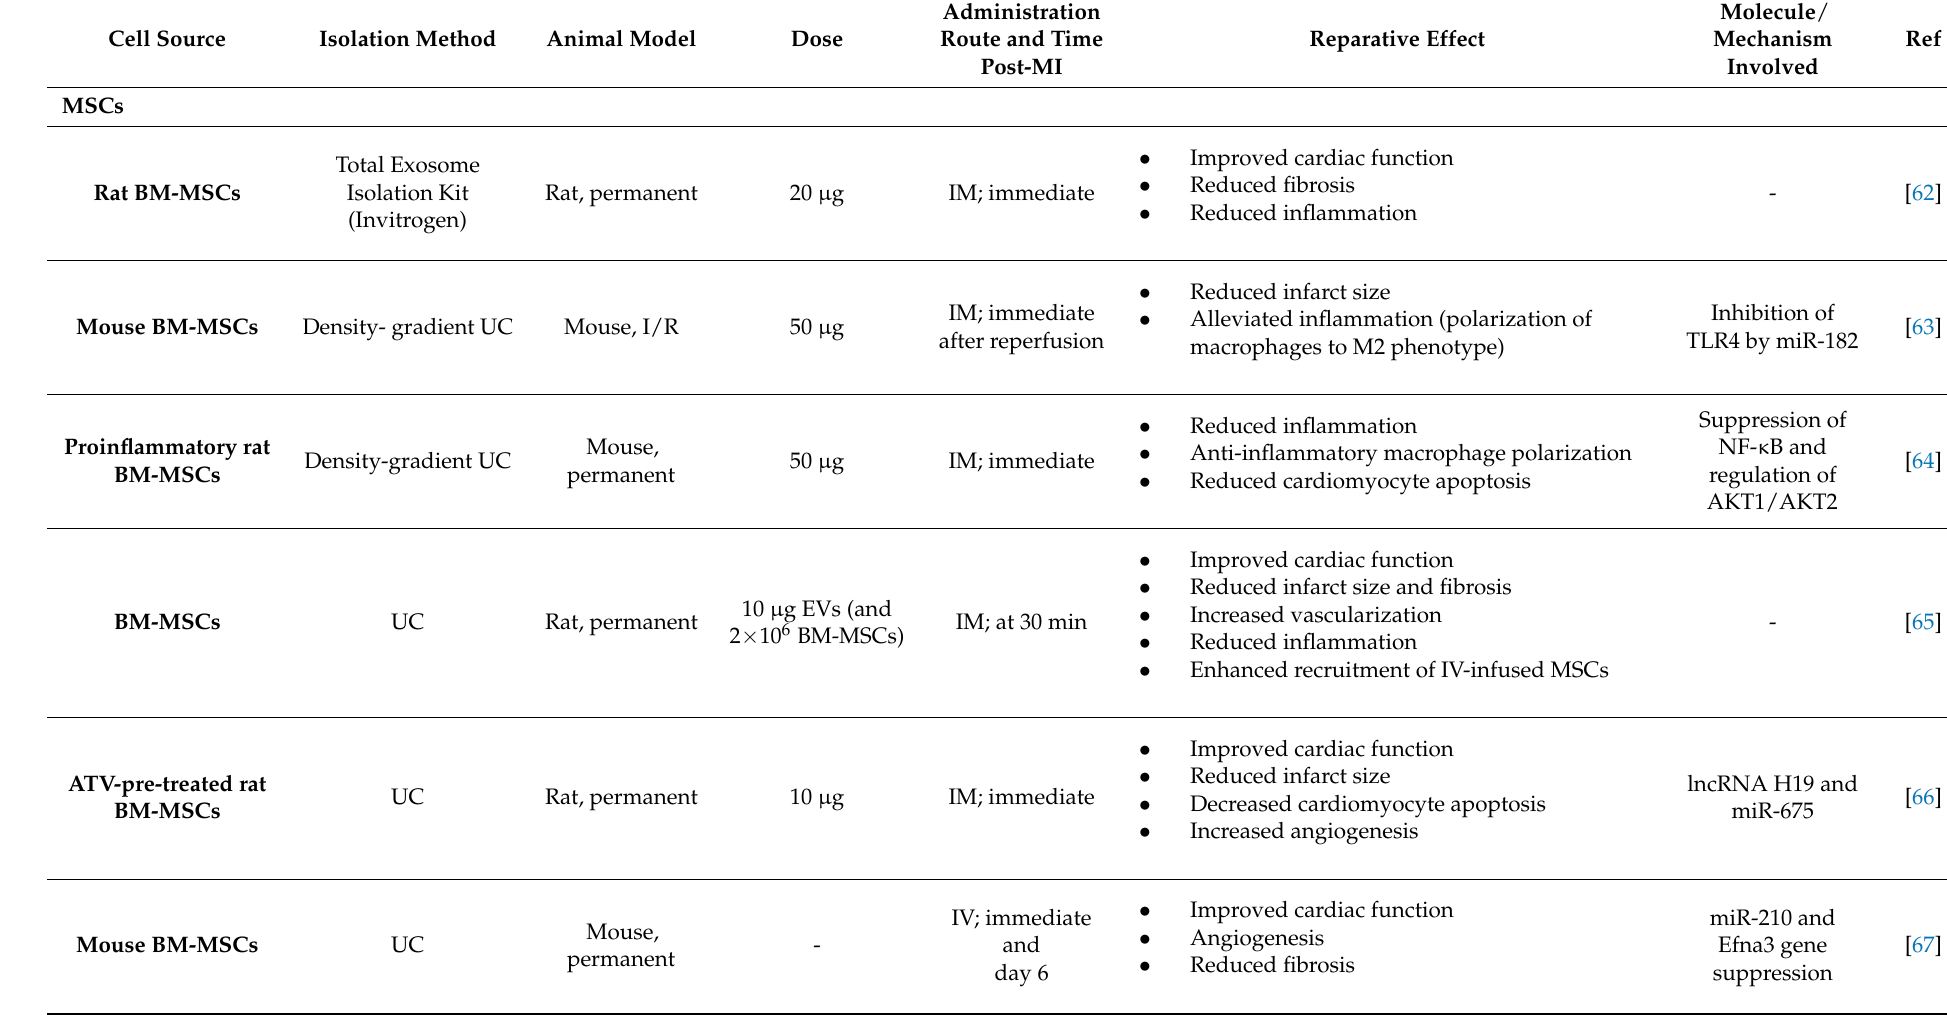
Table 2. Representative preclinical efficacy studies from the last five years, using extracellular vesicles as therapeutic agents for myocardial